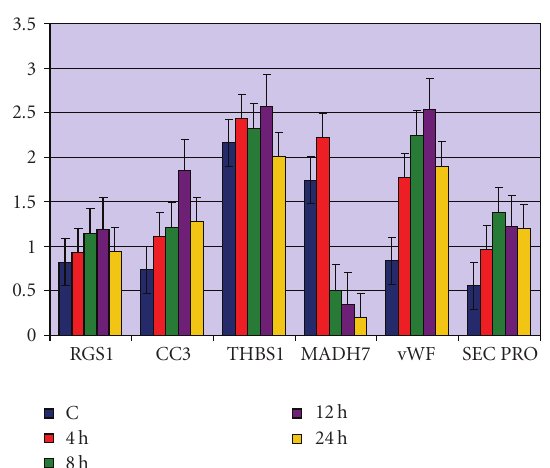
Figure 3: The expression of RGS1, CC3, THBS1, vWF, MADH7, and Sec Pro at various time points in irradiated HeLa cells.